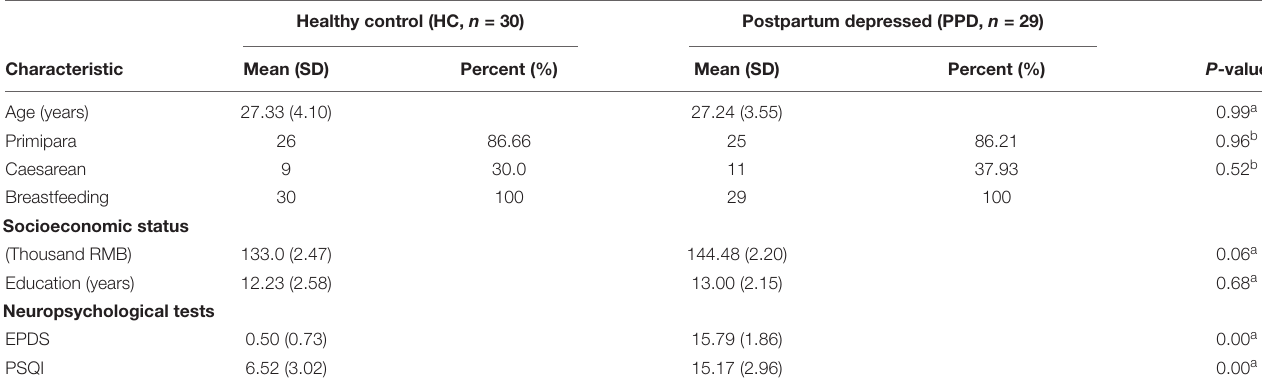
TABLE 1 | Demographic and clinical characteristics of